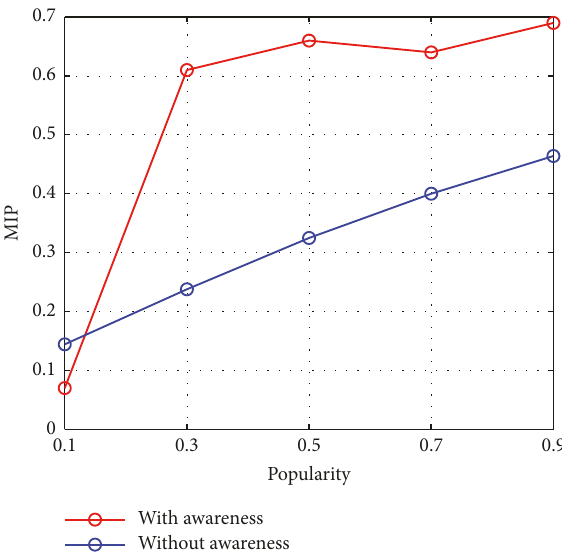
Figure 9: A comparison of 𝑀𝐼𝑃 between awareness and no awareness